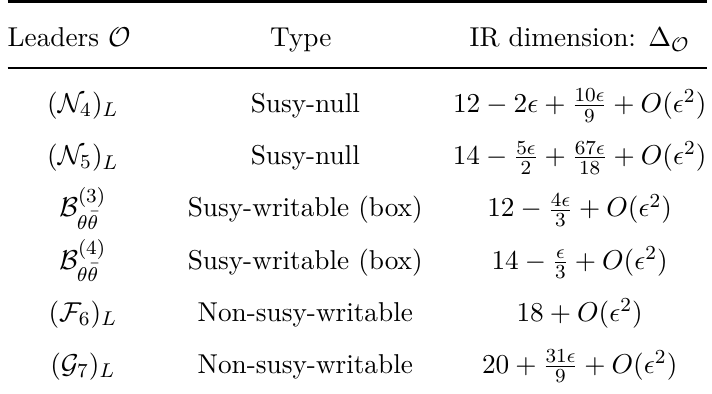
Table 1 . Summary of the computation of anomalous dimensions of the first leader operators of each type. The computations are performed in the L